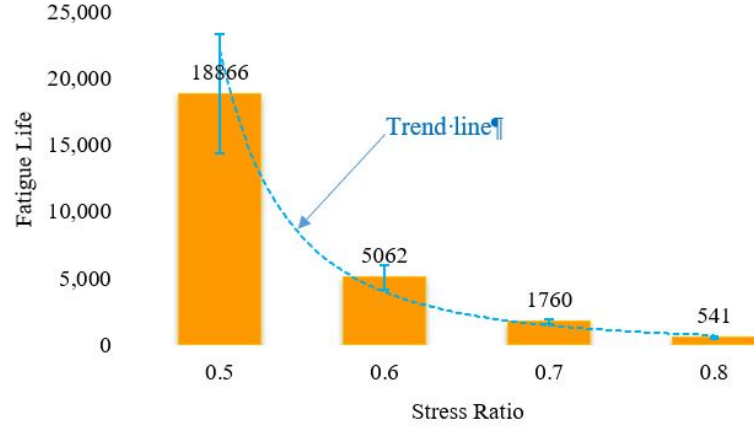
Figure 9. ECC fatigue lives under different stress ratios.